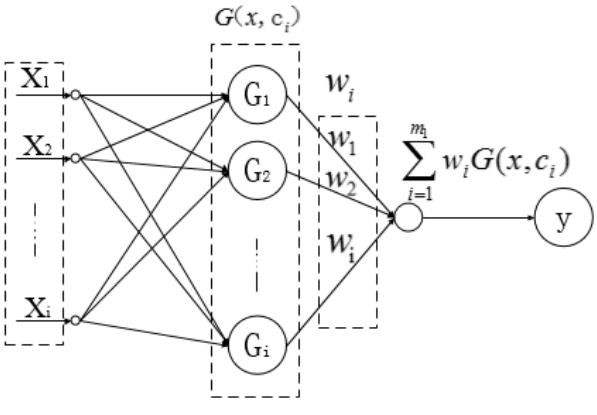
Figure 8. Regularization network structure.